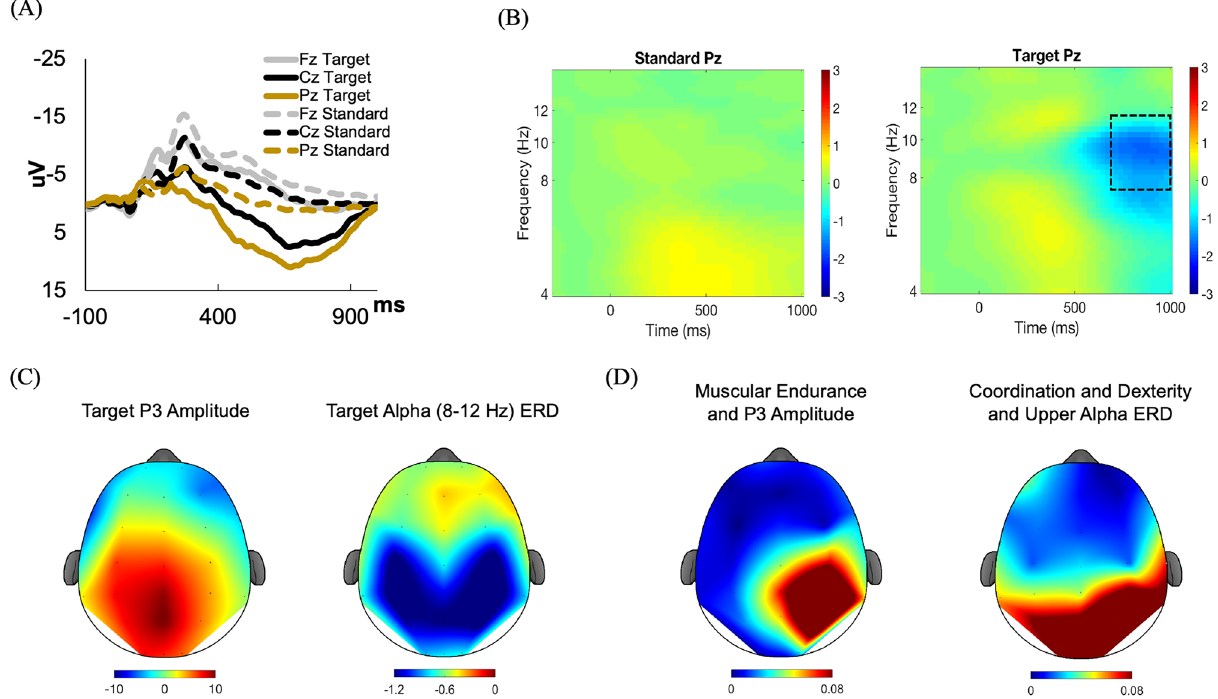
Figure 1. P3-ERP and alpha ERD during the auditory oddball task and their associations with muscular endurance and coordination and dexterity. ( A ) The ERP grand average waves show a P3 peaked around 650 ms after the onset of target stimulus (solid lines) at the Pz electrode (tan lines) while a weaker P3 was observed following standard stimulus (dashed lines) at Fz (gray lines) and Cz (black lines). ( B ) The time–frequency representation of oscillatory activities at Pz electrode shows a desynchronization of both lower (8–10) Hz and higher (10–12 Hz) alpha frequency from 700 to 1000 ms (dotted rectangle) following the onset of target (right) stimulus but not standard (left) stimulus. ( C ) The scalp distributions of P3 amplitude and the ERD at the alpha (8–12 Hz) band following the target stimulus were stronger at the parietal region. ( D ) The topographical distribution of the R 2 changes for each electrode obtained from the final step of the 3-step